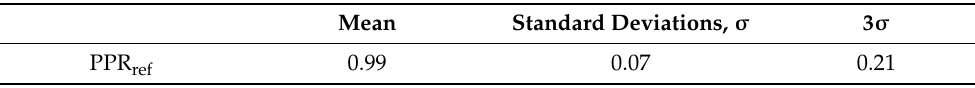
Table 2. Control limits for Shewhart